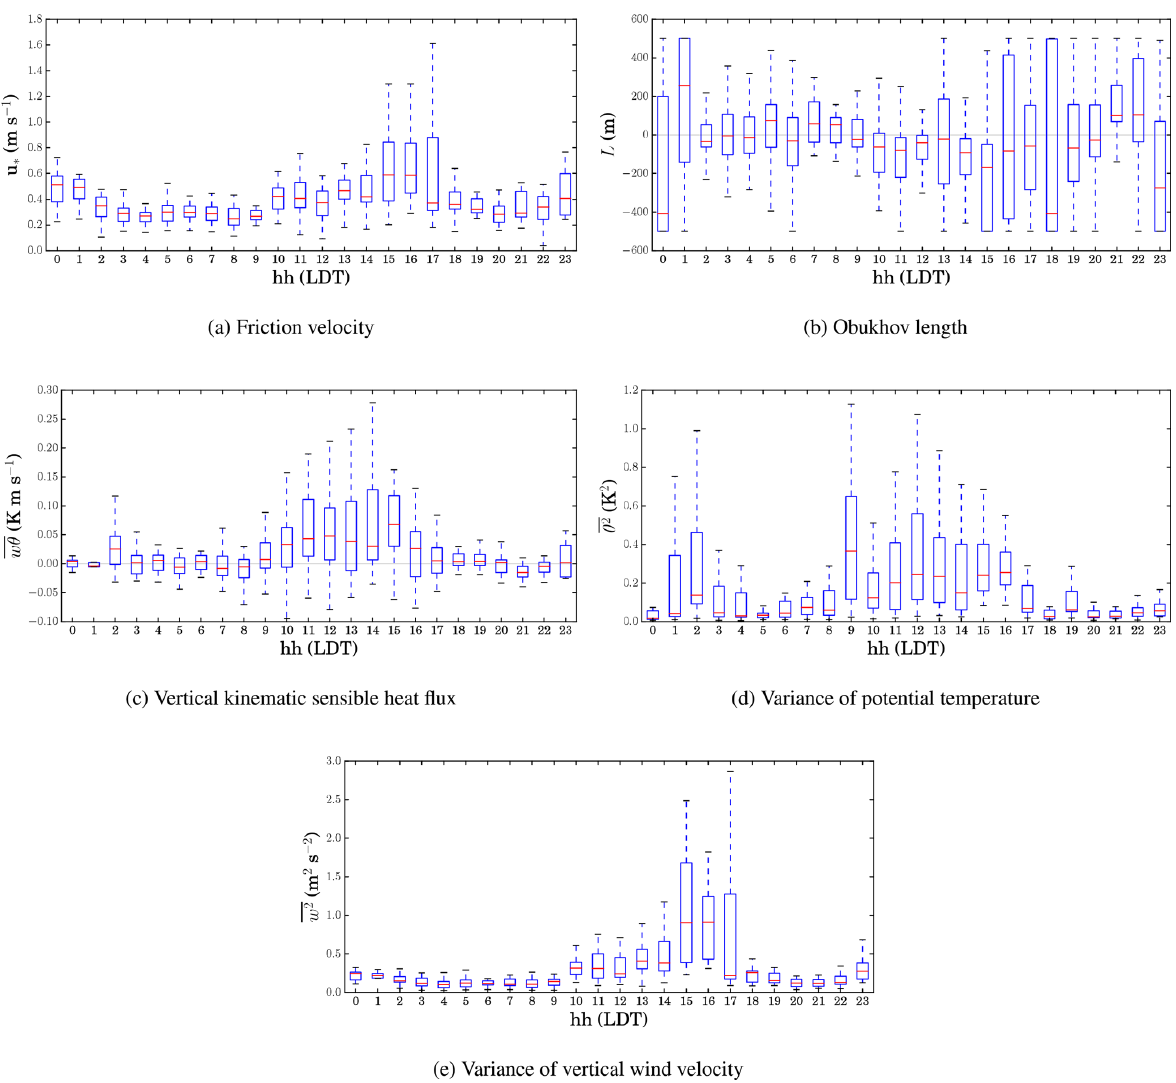
Figure 7. Diurnal variation of different turbulence statistics; at each hour, observations are plotted using statistical percentiles (5th, 25th, 50th, 75th, and 95th); times are in